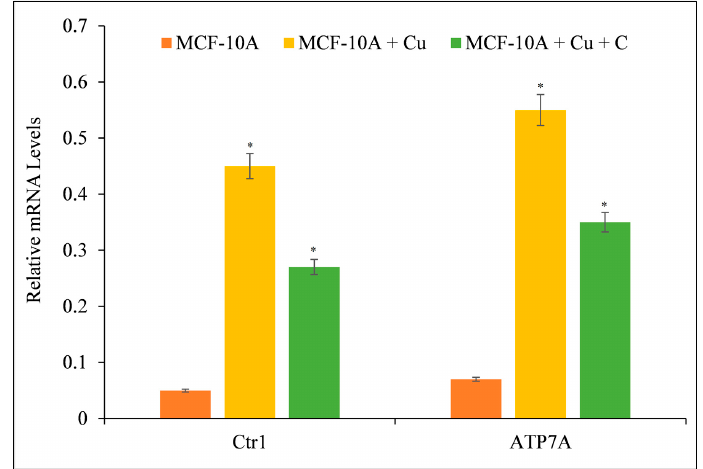
Figure 10. The effect of curcumin on the elevated mRNA transcript levels of copper transporters CTR1 and ATP7A in MCF ‐ 10A ‐ Cu cells relative to their parental MCF ‐ 10A cells. Total RNA was extracted utilizing TRIzol reagent (Invitrogen, Carlsbad, CA, USA) as directed by the manufacturer. As described in Section 2, CTR1 and ATP7A mRNA expression was quantified using real ‐ time PCR. To determine the effect of curcumin on mRNA expression, only MCF ‐ 10A+Cu cells (normal MCF ‐ 10A cells grown in a medium containing 25 μ M CuCl 2 ) with enhanced mRNA expression of copper transporters were treated with 25 μ M curcumin. Values reported are ±S.E.M. of three independent experiments. * p value < 0.05 when compared to control.